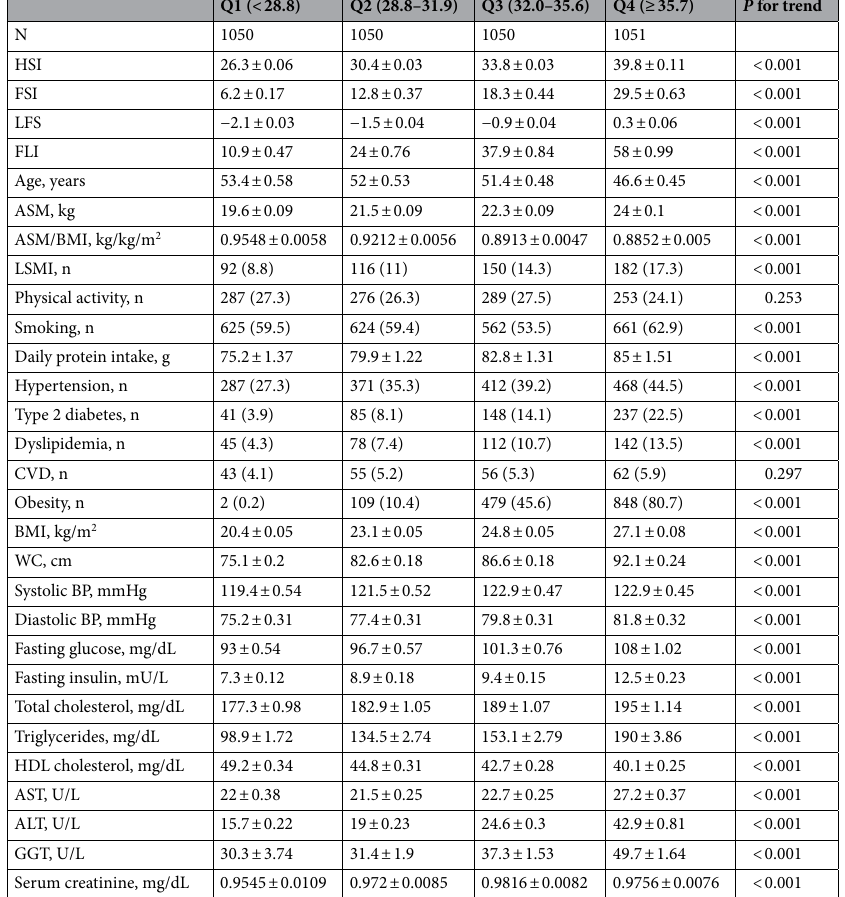
Table 3. General characteristics of Korean men based on quartile of HSI level. HSI hepatic steatosis index, FSI Framingham steatosis index, LFS NAFLD liver fat score, FLI fatty liver index, ASM appendicular skeletal aminotransferase, GGT gamma-glutamyl